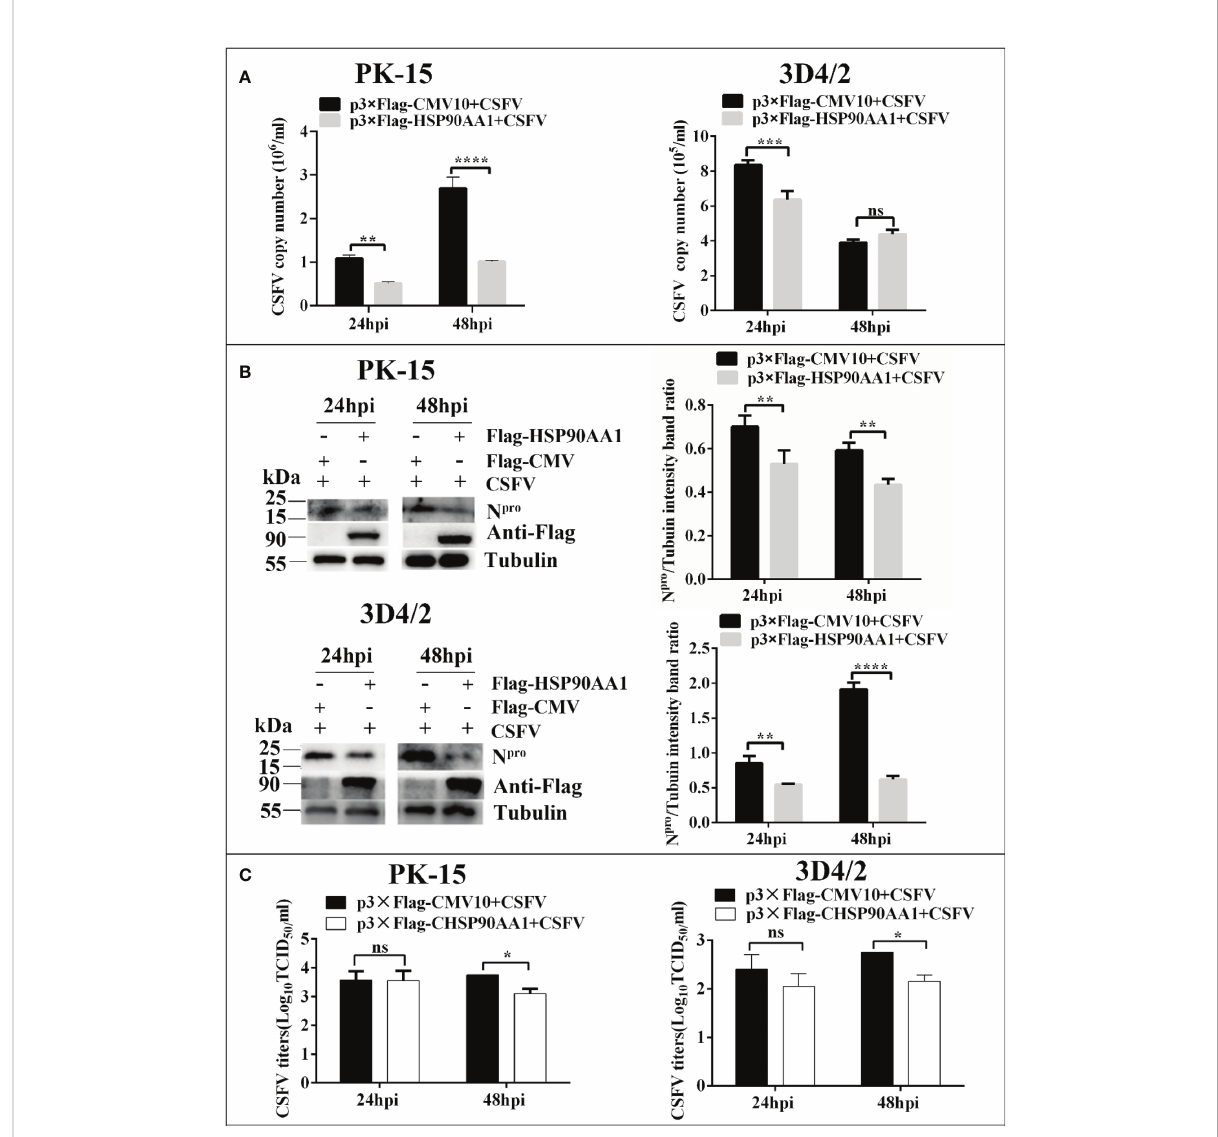
FIGURE 2 Over-expression of HSP90AA1 inhibits CSFV replication. (A) CSFV NS5B copy numbers were determined by RT-PCR at 24 and 48 hpi in HSP90AA1-overexpression PK-15 and 3D4/2 cells. (B) Western blot for HSP90AA1 and CSFV N pro expression in HSP90AA1-overexpression PK-15 and 3D4/2 cells, and the relative protein levels of N pro in HSP90AA1-overexpression PK-15 and 3D4/2 cells were estimated by histograms representing density readings of the gel bands with Image J, and the ratios were calculated relative to Tubulin control. (C) Infectious progeny viral titers in supernatants from HSP90AA1-overexpressing PK-15 and 3D4/2 cells. Viral titers from the supernatants collected at 24 and 48 hpi were determined and expressed as TCID 50 /ml. (*p < 0.05, **p < 0.01, ***p < 0.001 and ****p < 0.0001 calculated using two-way ANOVA. ns, not signi fi